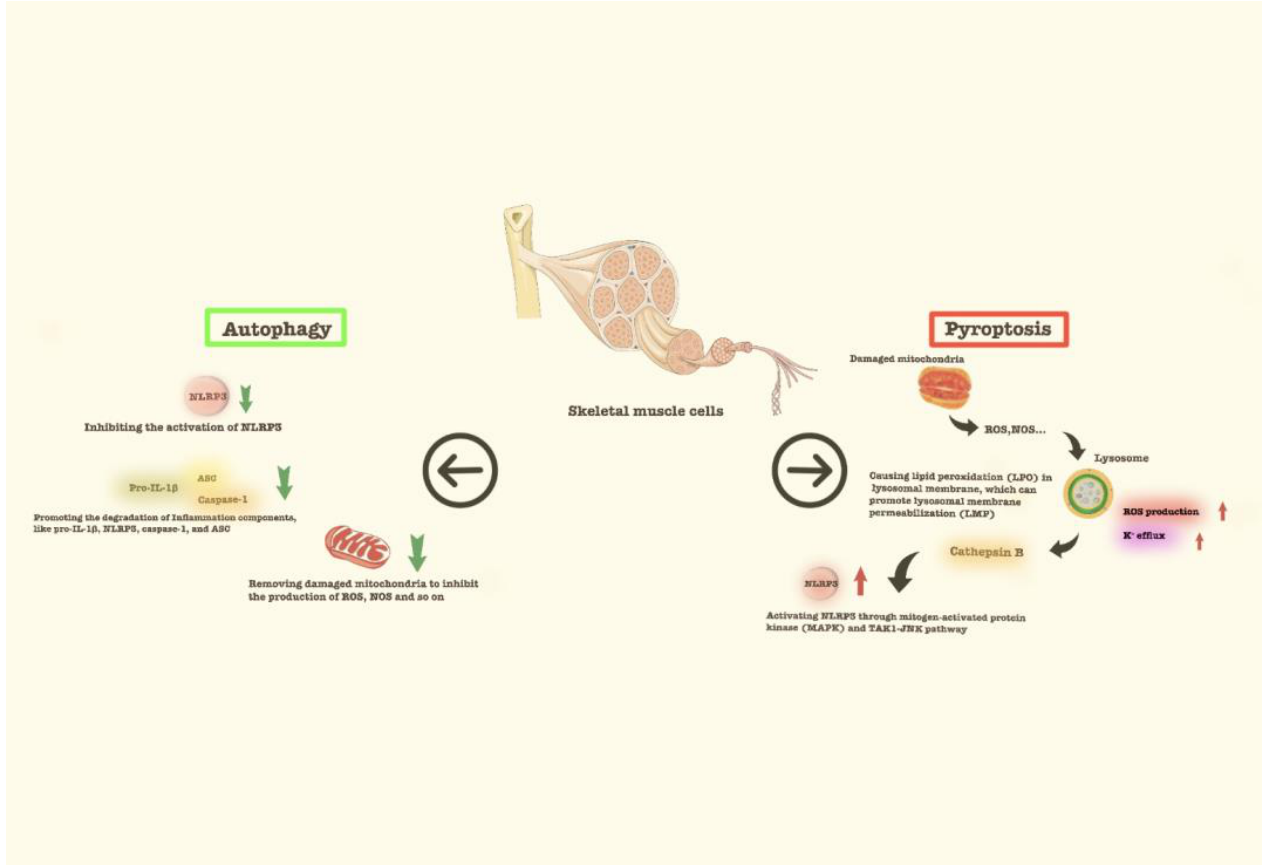
Figure 1. The autophagy of skeletal muscle cells in normal conditions can inhibit the activation of the pyroptosis to some extent. Autophagy can inhibit the activation of the nod-like receptor 3 (NLRP3) inflammasome by removing the damaged mitochondria, inhibiting the production of oxidizing agents, and promoting the degradation of inflammation components, such as pro-Interleukin-1 β (pro-IL-1 β ), NLRP3, caspase-1, and apoptosis-associated speck-like protein containing a caspase recruitment domain (ASC).